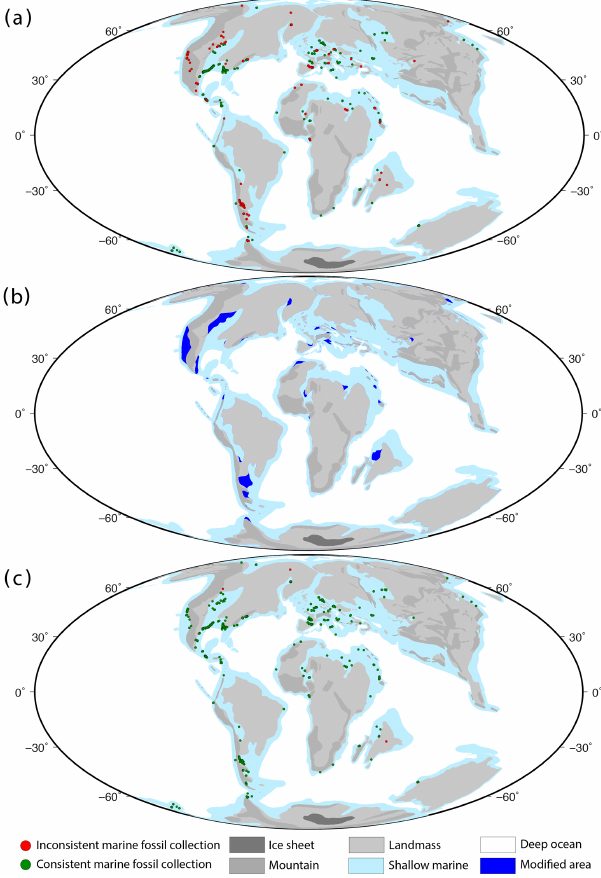
Figure 4. (a) Test between the global paleogeography at 76Ma re- constructed using the plate motion model of Matthews et al. (2016) with gaps fixed and the paleoenvironments indicated by the marine fossil collections from the PBDB. (b) Area modified (blue) to re- solve the test inconsistencies. (c) Test between the revised paleo- geography at 76Ma and the same marine fossil collections. Moll- weide projection with 0 ◦ E central